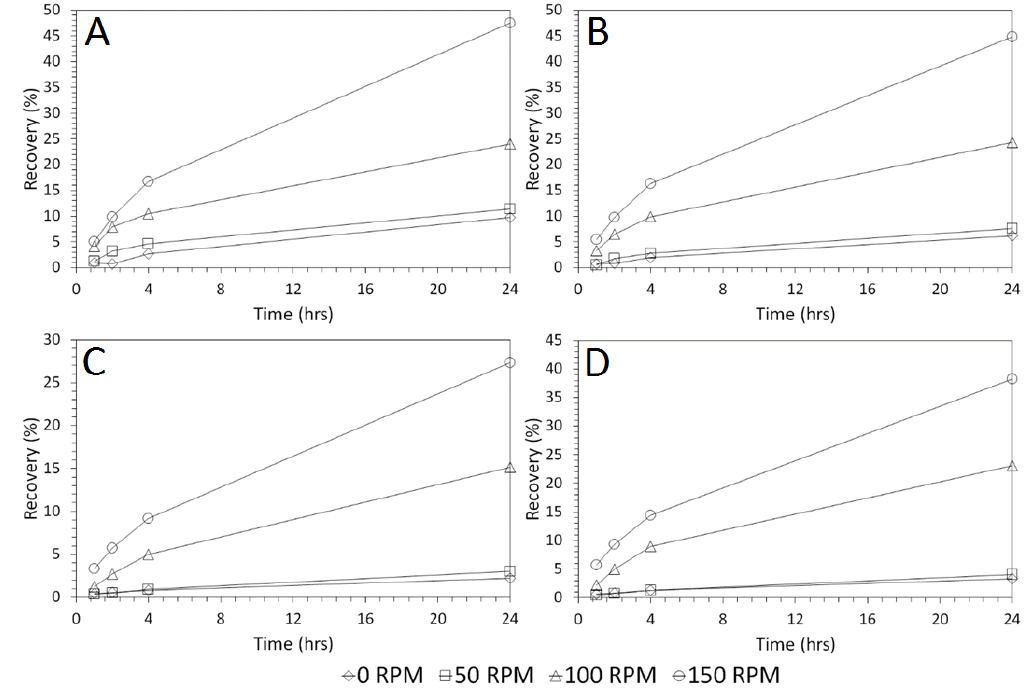
Figure 11. As recovery as a function of time for mixing speeds of 0, 50, 100, and 150 RPM using: H 2 SO 4 ( A ), HCl ( B ), C 6 H 8 O 7 ( C ) and CH 3 SO 3 H ( D ). The acid concentrations were 1 M and the lixiviant volumes were 200 mL.